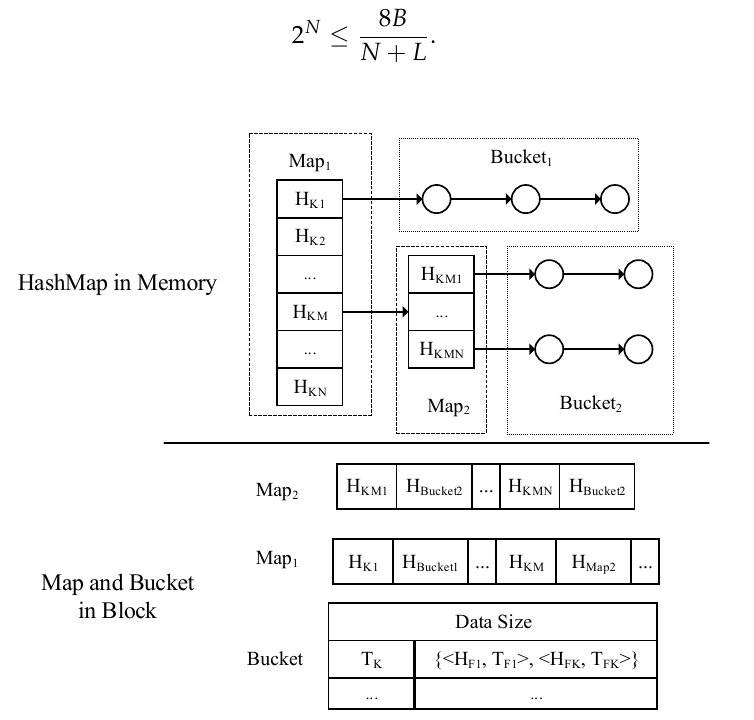
Figure 4. The structure of